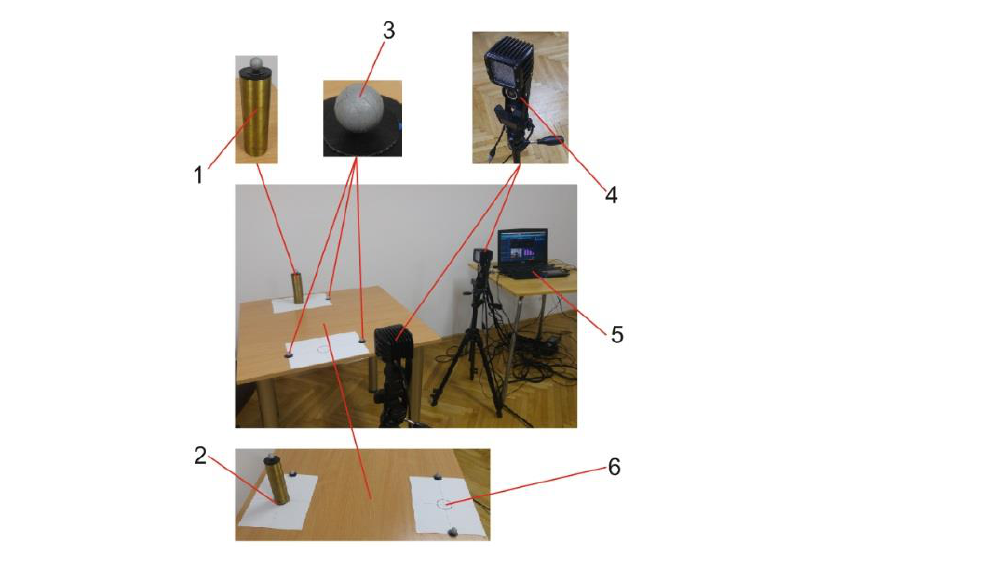
Figure 4. Stand for examining precise hand movements: 1 — transferred object, 2 — initial area in which the transferred object is located, 3 — position marker, 4 — stereovision camera, 5 — device for data acquisition and processing, 6 — area in which the transferred object should be located.